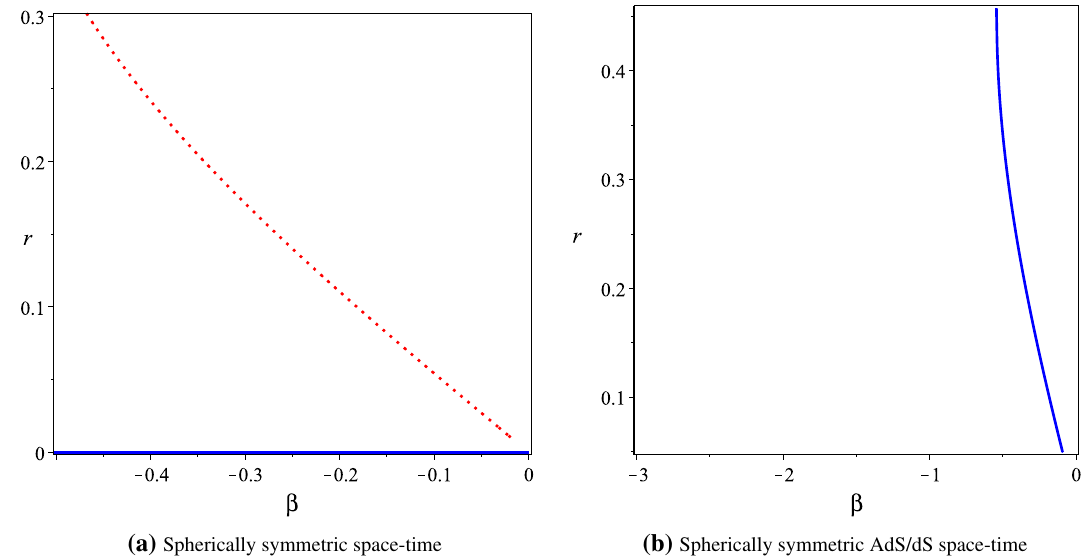
( a ) Spherically symmetric space-time (b) Spherically symmetric AdS/dS space-time Fig. 8 Schematic plot of the radial coordinate r versus the dimensional parameter β that characterizes the spherically symmetric black holes